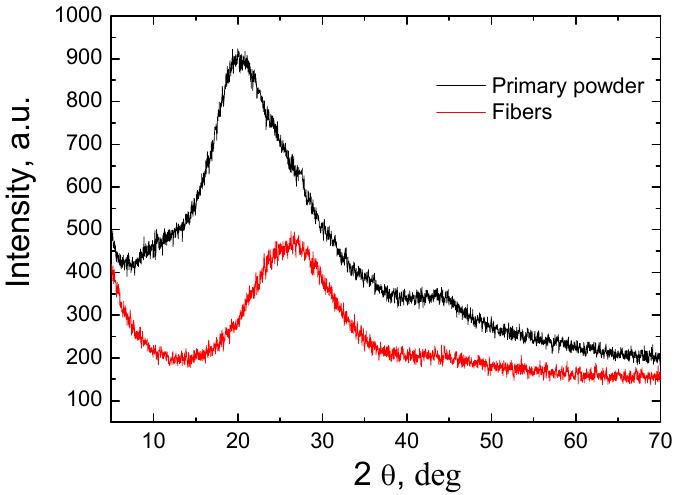
Figure 4. The XRD study results of the primary powder and fiber. The FTIR transmittance spectrum of the powder was characterized by a wide O-H band at 3440 cm − 1 and an intense C-H band at ~2920 cm − 1 in range of 2800–3100 cm − 1 , which are typical stretching vibrations of CH, CH 2 and CH 3 groups. The high intensity and narrow low intensity absorption peaks at 1720 cm − 1 and 1600 cm − 1 are assigned to the C=O and C=C groups, respectively. The peak at ~1443 cm − 1 is due to C-C stretching vibrations in aromatic rings or C-H group vibrations. The absorption bands at 1061 cm − 1 and 1248 cm − 1 are attributed to the C-O stretching vibrations. The peak at ~1120 cm − 1 is related to the vibrations of Si-O-C and/or C-O-C bonds. The sharp peaks at 740 cm − 1 and 700 cm − 1 are assigned to C-H out of plane of aromatic rings [28–31]. The existence of these characteristic absorption peaks was caused because the powder contained a large amount of epoxy resin, which is used to attach individual parts of the wind turbine blades—a significant part of which is of an organic origin [29–31]. The EDS measurements indicated the presence of low amount of Si, Ca and Al in the powders. Meanwhile, the SiO 2 , CaO